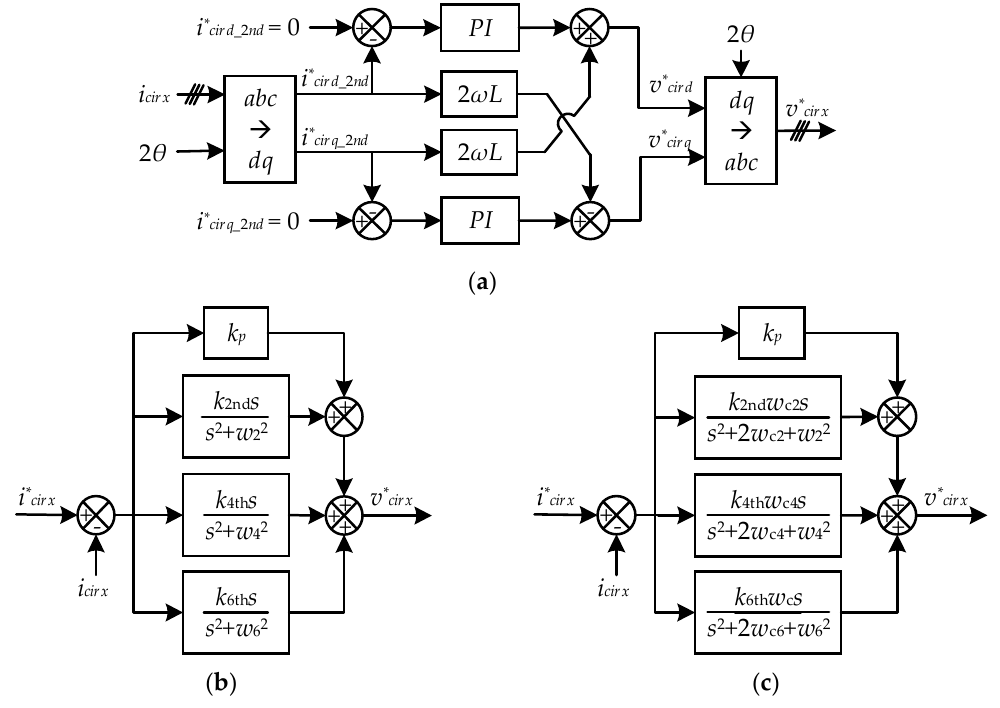
Figure 14. Circulating current control: ( a ) Decoupling control in the dq -frame; ( b ) Proportional resonant control; ( c ) Quasi proportional resonant control.